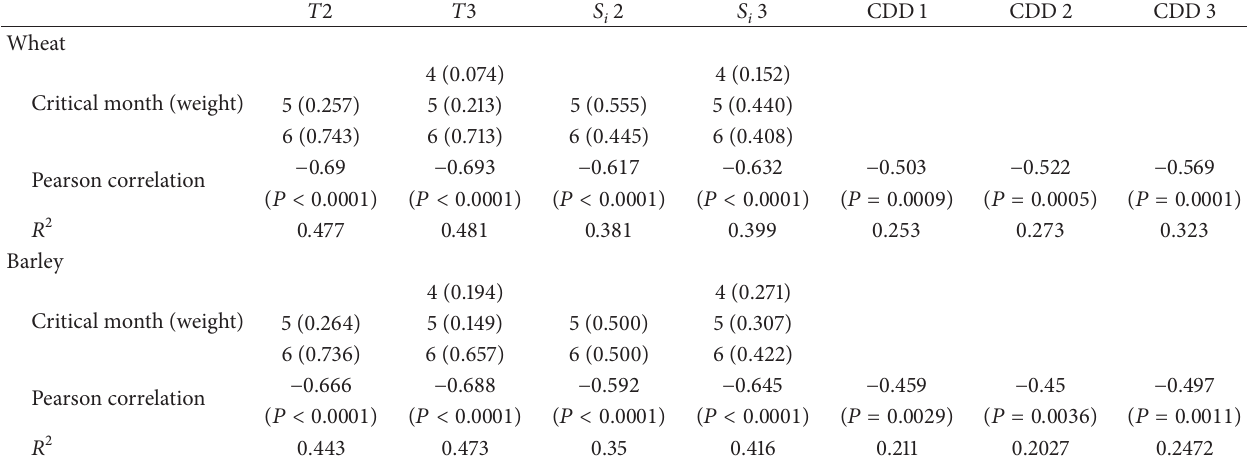
Table 2: The results of the test of various weather